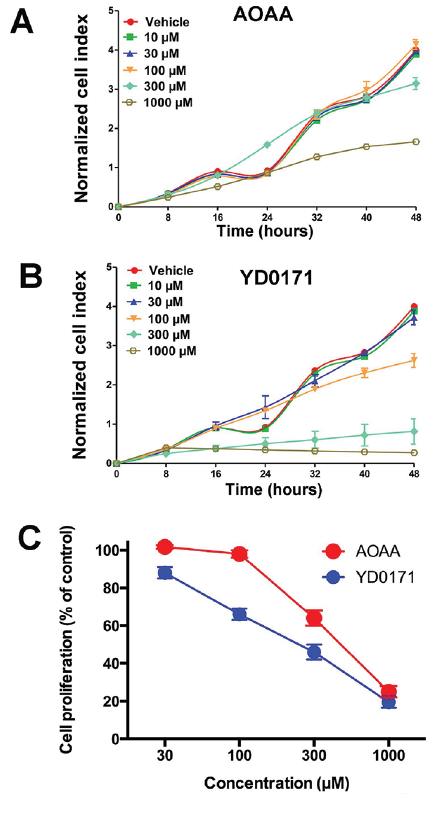
Figure 13. Inhibition of cell proliferation and H S production by YD0171 in HCT116 2 cells. (A) Cells were treated with various concentrations of AOAA or YD0171 in 96-well xCELLigence plates, and prolifer- ation was monitored for 48 h. Cell pro- liferation is shown over time for AOAA (top panel) and YD0171 (bottom panel) treated cells from one representative experimental run. Note that AOAA only inhibited cell proliferation at the highest concentration tested (1 mmol/L), while the inhibitory effect of YD0171 on cell prolifera- tion was already apparent at 100–300 μ mol/L. (B) Summary data (mean ± SEM) of n = 6 independent experiments testing the effect of AOAA and YD0171 in cultured HCT116 cells. Cell proliferation at 48 h is expressed as 100%. YD0171 inhibited the proliferation with an IC of 200 μ mol/L, 50 while the IC50 of AOAA was 500 be either related to a differential turn- over rate of hepatic versus intratumor CBS enzyme and/or due to the high efficiency of the hepatocytes to metabolize